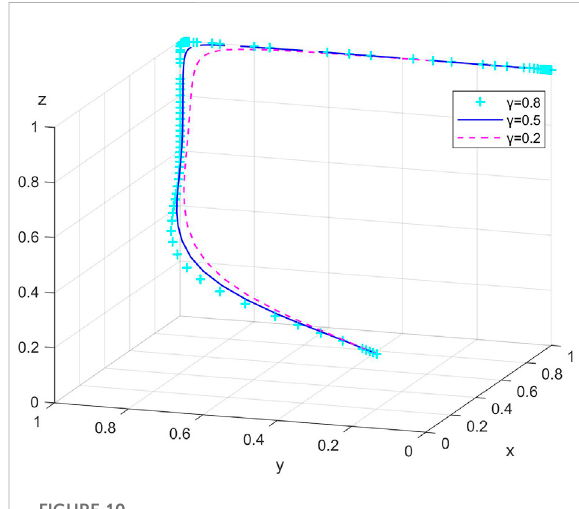
FIGURE 10 Impact of the proportion of enterprises ’ self-operated waste reverse